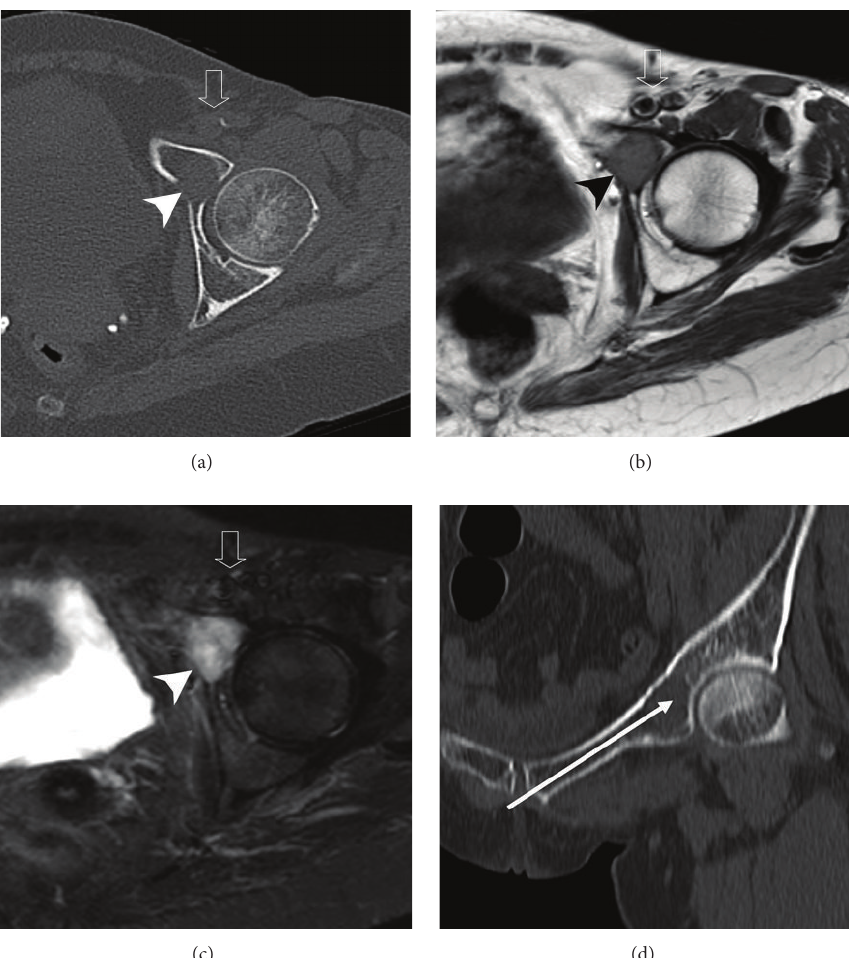
Figure 1: 60-year-old-female with metastatic lung cancer complaining of left hip pain. (a) Nonenhanced axial CT image demonstrates left anterioracetabularosteolyticlesion(arrowhead)withanteriorcorticalthinningandposteriorcorticalbreach.(b)and(c)Theacetabularlesion (arrowhead) shows low signal intensity on axial T1W image (b) and high signal intensity on axial STIR image (c). Note its close relationship with the femoral neurovascular structures precluding a direct anterior approach (open arrow). (d) Coronal oblique reformatted CT image shows the needle path from the skin entry to the target lesion (long